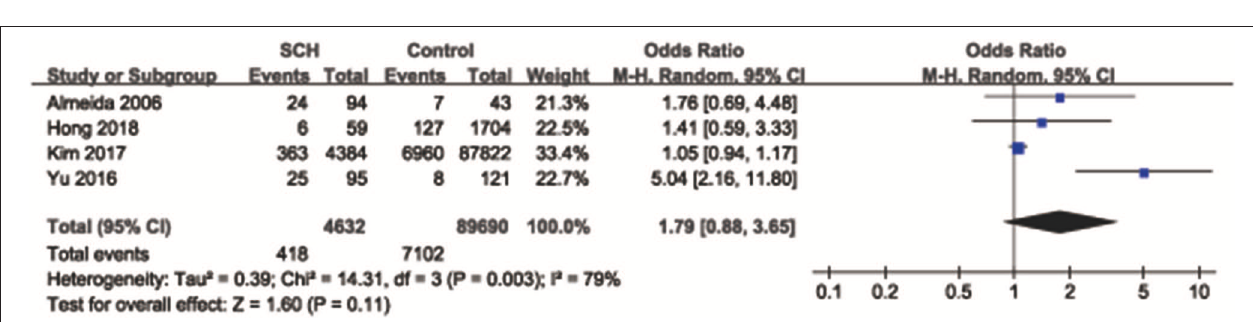
FIGURE 4 | Subgroup analysis for the association between subclinical hypothyroidism and depression in the participants with a mean age of < 50 years. SCH, subclinical hypothyroidism; CI, confidence interval.